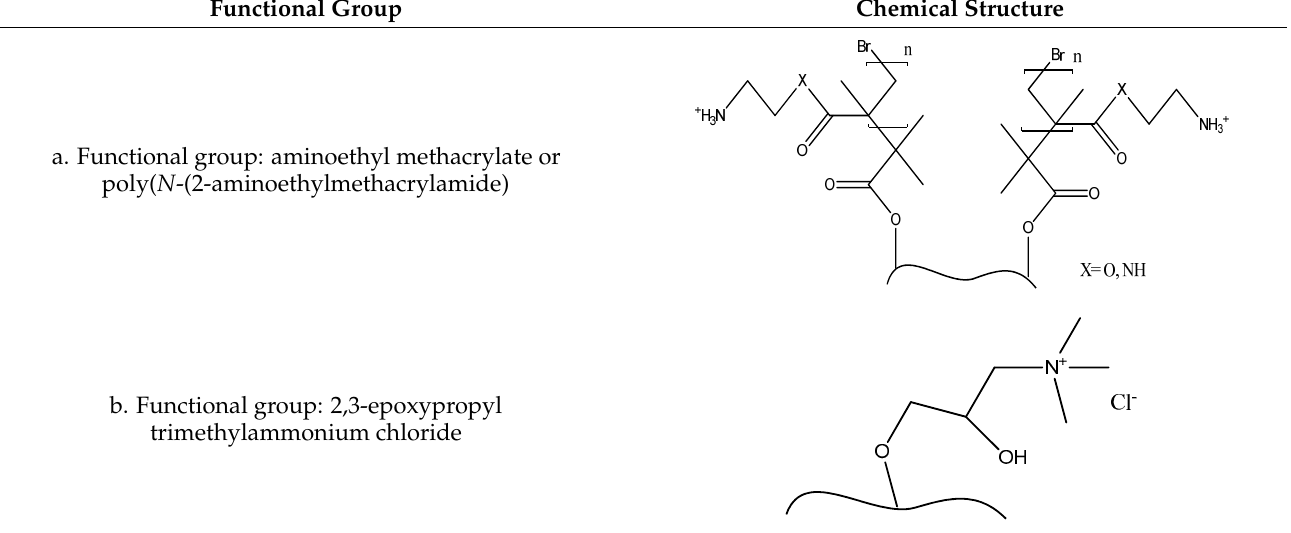
Table 6. Functionalized nanocellulose with quaternary compounds for virus removal applications. Functional Group